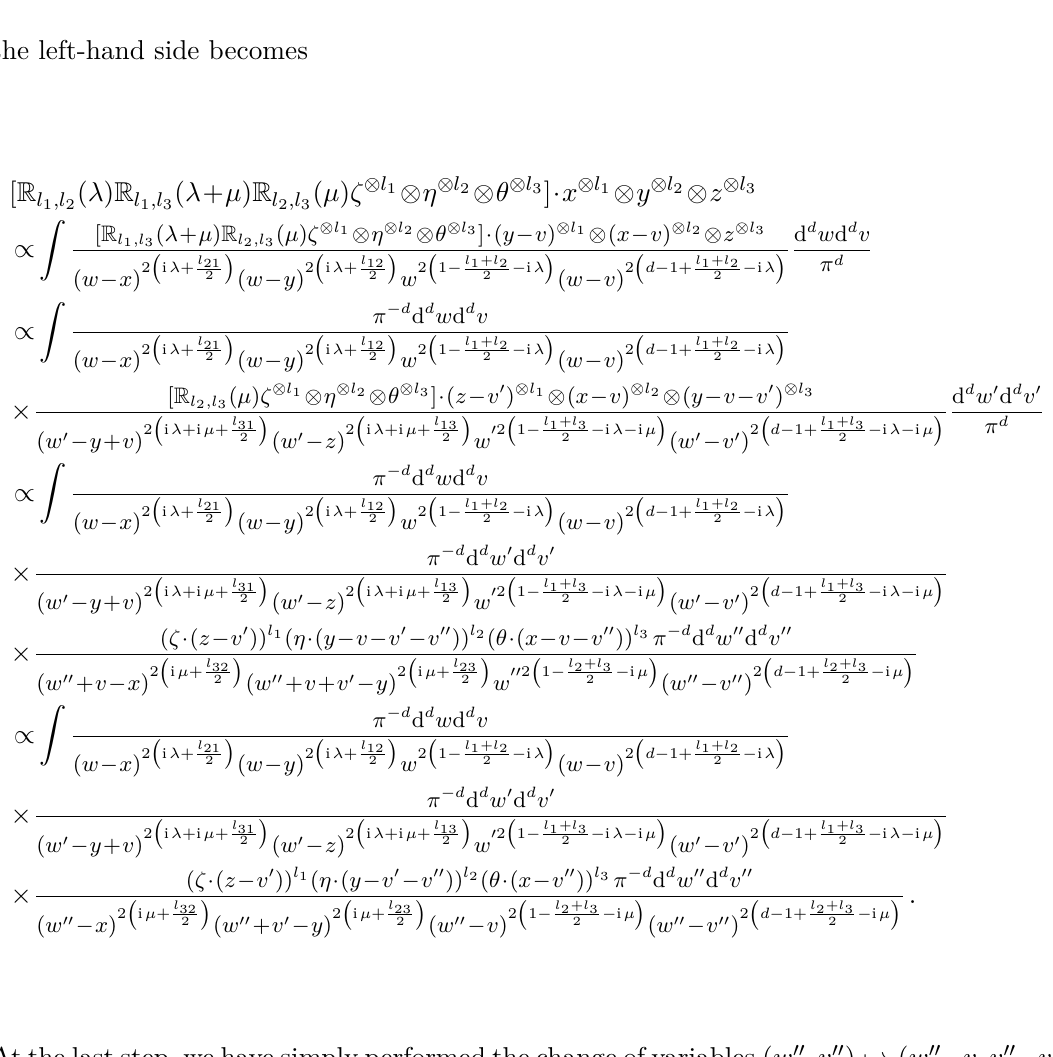
( u ) introduced in figure 2. 1 l 2